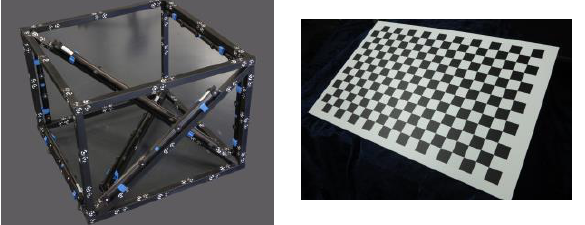
Figure 3. Volumetric VDI testfield and planar chess board